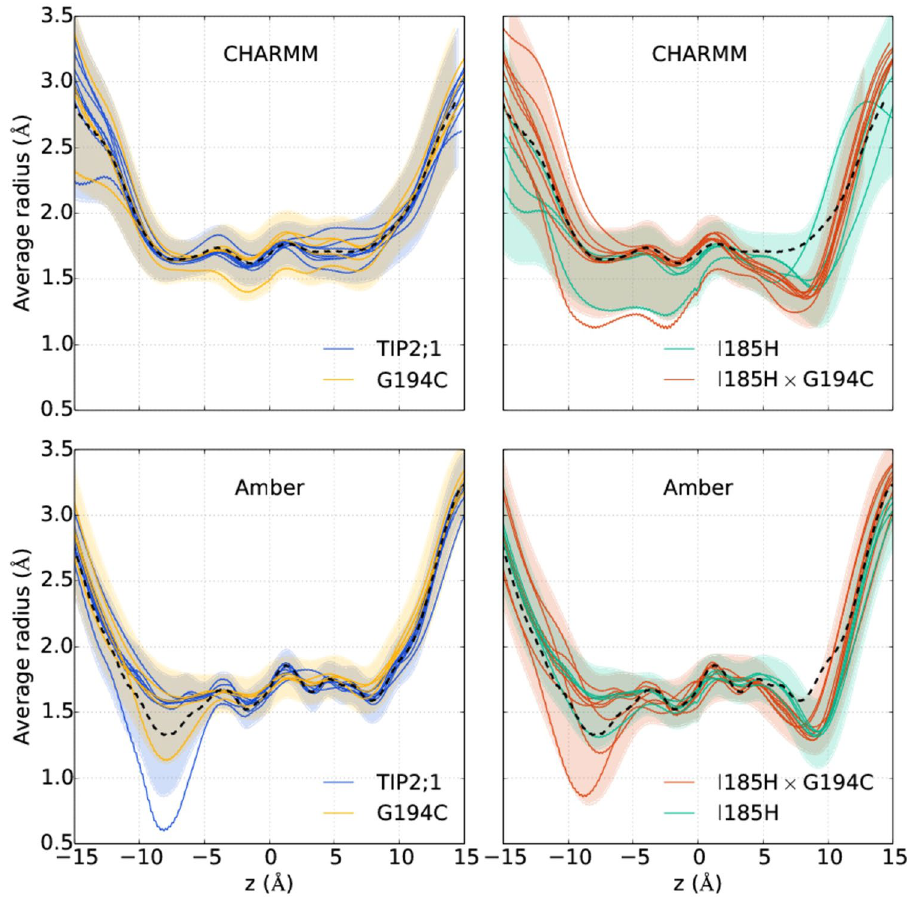
Figure 3. Average pore radius of TIP2;1 and mutants as a function of the channel axis z . Each profile is obtained by averaging over 1 μ s long trajectories. Different profiles of the same color correspond to different monomers of the same system. The dashed, black profile of each panel is the average over monomers for TIP2;1 (for the respective force field). For certain systems, there is data from two simulations yielding eight profiles in total. Error bars show the root-mean square deviation as a function of z for all trajectories of the same system, concatenated. For a few monomers of CHARMM, structural changes involving the NPA region (discussed in the main text) are evident from the decrease in radius in the bottom part of the pore. For Amber, in certain monomers a structural change involving H81 closes the pore on the cytoplasmic side, leading to a local decrease in pore